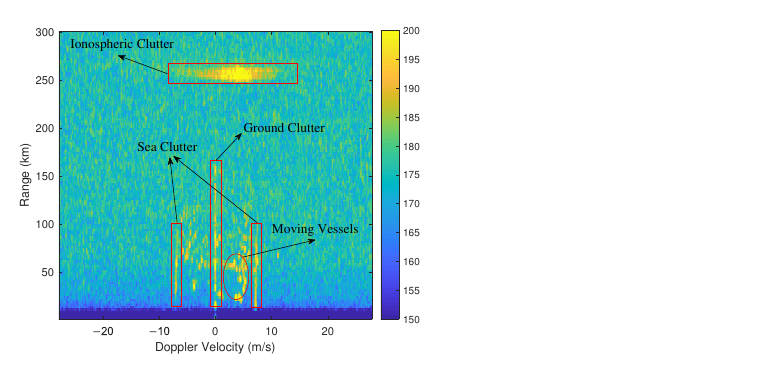
Figure 1. Moving vessels and clutters in an R-D map obtained from a compact